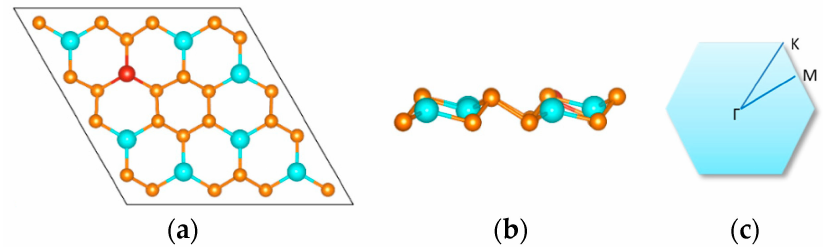
Figure 1. Top ( a ) and side ( b ) views of monolayer GaP 3 structure. The blue, orange and red balls represent Ga, P and TM dopant (Ti, V, Cr, Mn, Fe, Co, Ni), respectively. The first Brillouin zone with high symmetry k points ( Γ , M and K) is shown in ( c ).